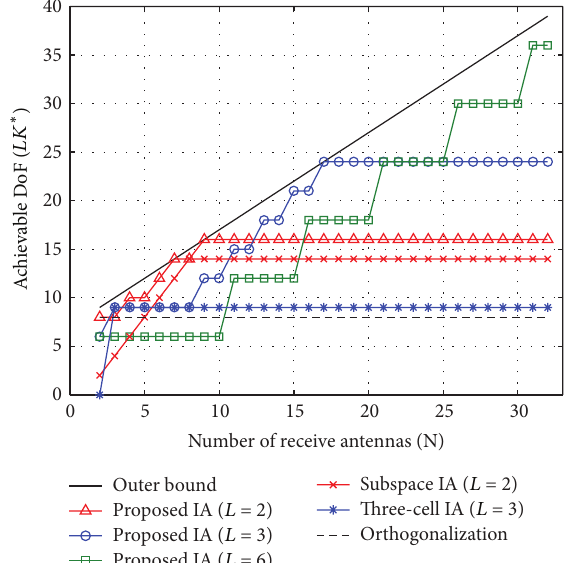
Figure 5: Achievable DoF versus number of receive antennas when 𝑀 = 8 .